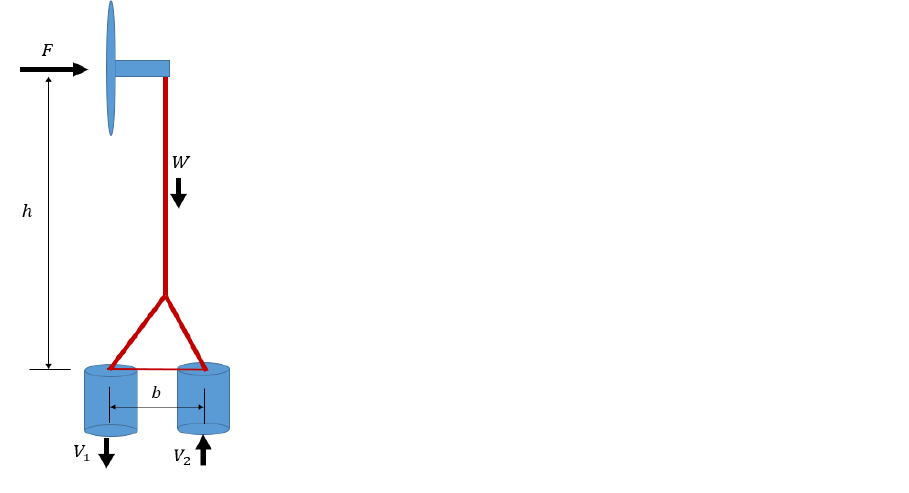
Figure 6. Simplified loading mechanisms for suction-bucket-supported OWT.